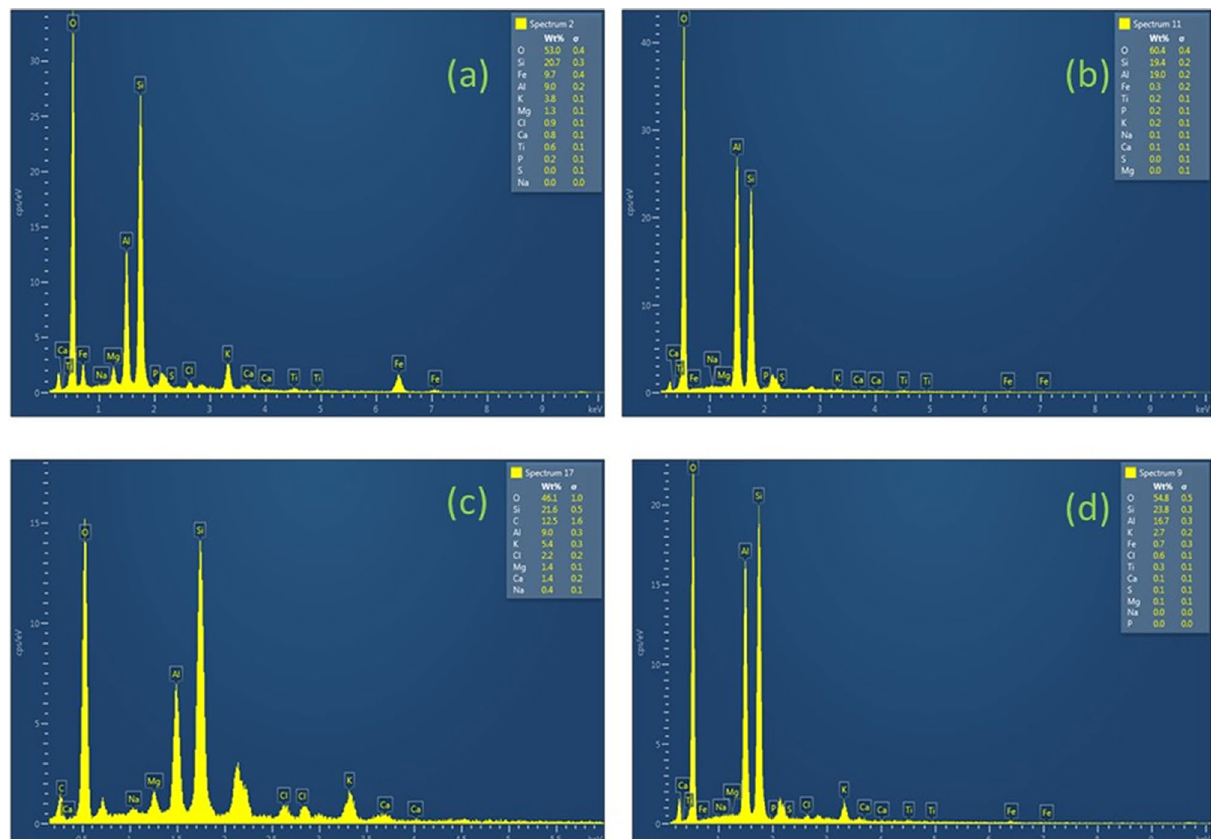
Figure 7. EDX spectra of ( a ) kaolin sample in the kaolin-GB layered system post equilibration with 0.5 M KCl, ( b ) kaolin sample in the natural condition, ( c ) Individual GB layer post permeation with 0.5 M KCl, and ( d ) GB sample of the kaolin-GB layer post permeation with 0.5 M